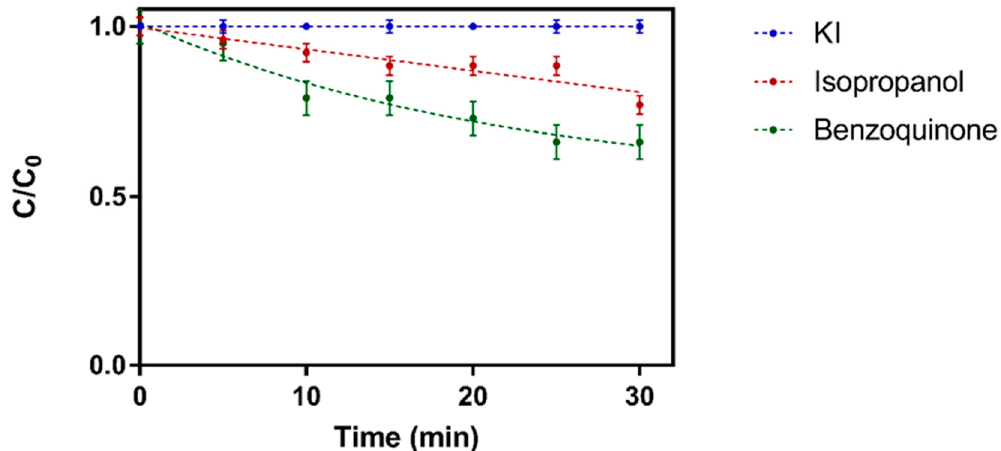
Figure 16. Zeroth-order degradation plot for Atrazine given treatment with BiOCl in the presence of isopropanol, KI and benzoquinone and 254 nm light. Reused with permission from reference [137]. Copyright Elsevier 2018.